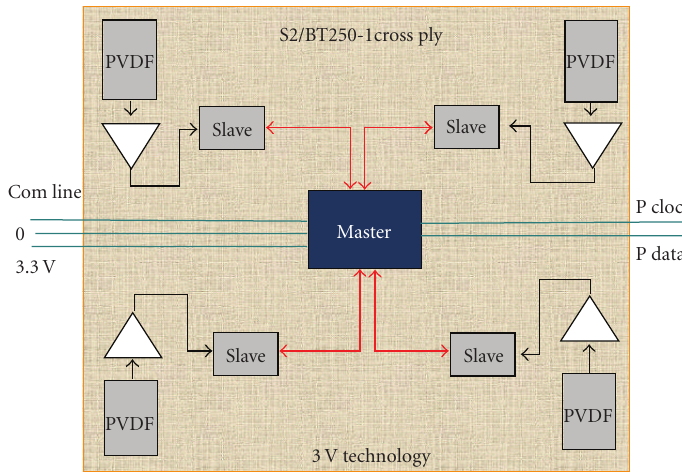
Figure 1: Schematic of one module of a 4-tree hierarchical